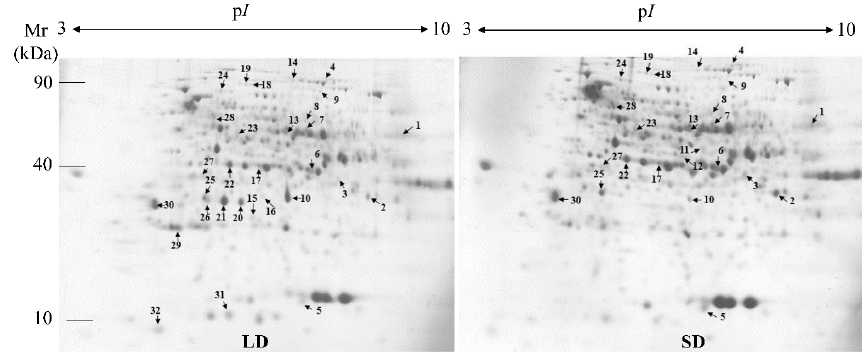
Figure 4. Representative 2-DE gel maps of proteins in the crowns of strawberry plants grown with strawberry plants with runners (LD) and without runners (SD) photoperiods. The 2-DE were replicated three times and the significant differences were calculated by Student’s t -test. Numbers and arrows indicate the di ff erentially expressed protein (DEP) spots with at least 2-fold changes between the crown with and without